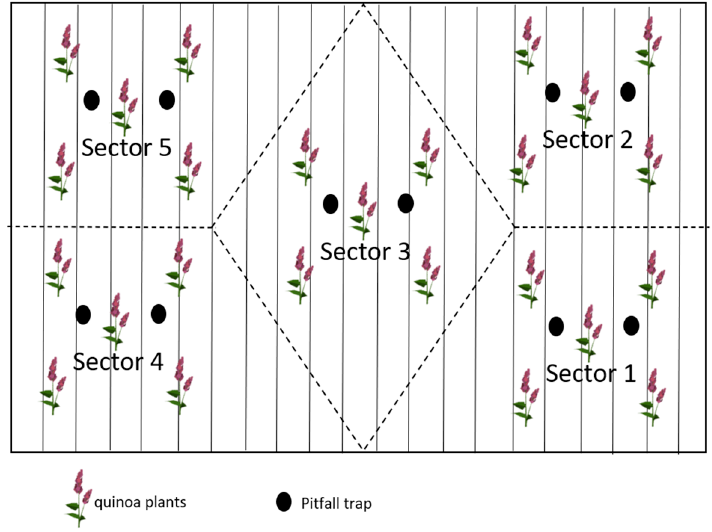
Figure 1. Sectorization and sampling scheme applied to the monitored fields. Transversal lines represent the direction of the furrows.